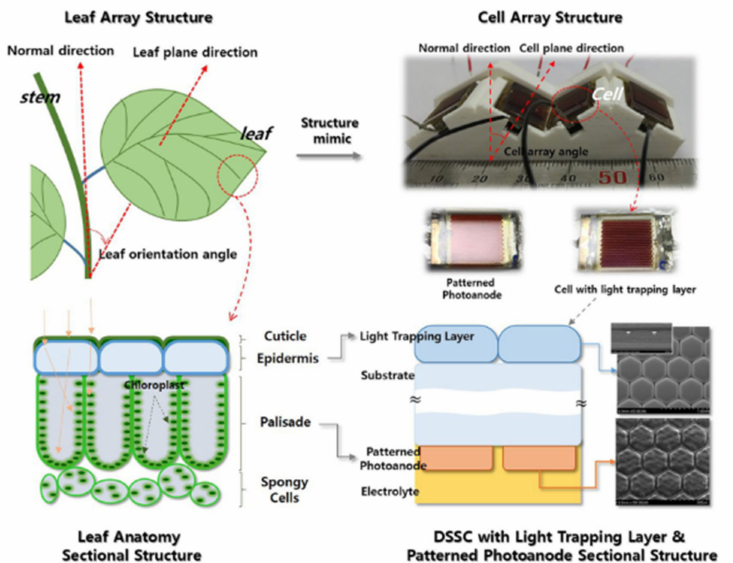
Figure 9. Anatomical structure of plant leaves as a basis for dye-sensitized solar cell (DSSC) configu- ration [28]. No changes were made to the original